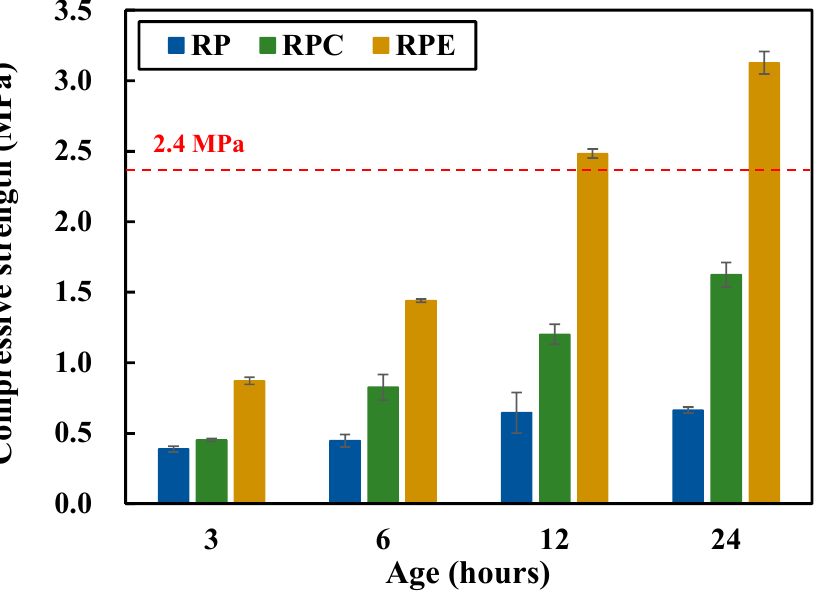
Figure 3. Compressive strength results for red clay binder specimens.